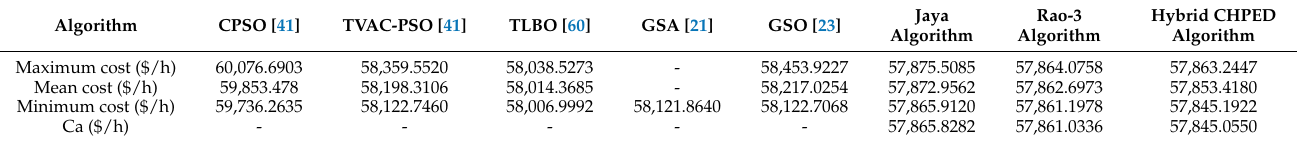
Table 4. Statistical analysis of case 1 of test system